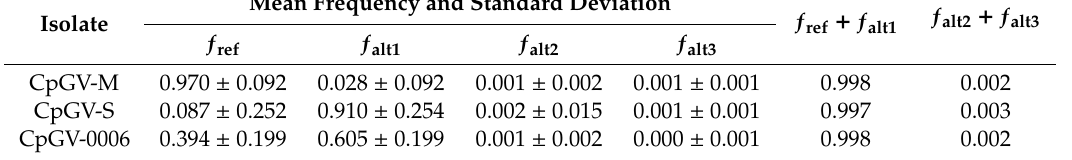
Table 2. Mean frequencies of the reference ( ƒ ref ) and three alternative nucleotides ( ƒ rel1 , ƒ rel2 and ƒ rel3 ). Frequencies were calculated from the 284 SNP positions referring to the mappings of short-read sequencing data of CpGV-M, CpGV-S and CpGV-0006 against CpGV-M reference sequence. Given are the arithmetic means and standard deviation.